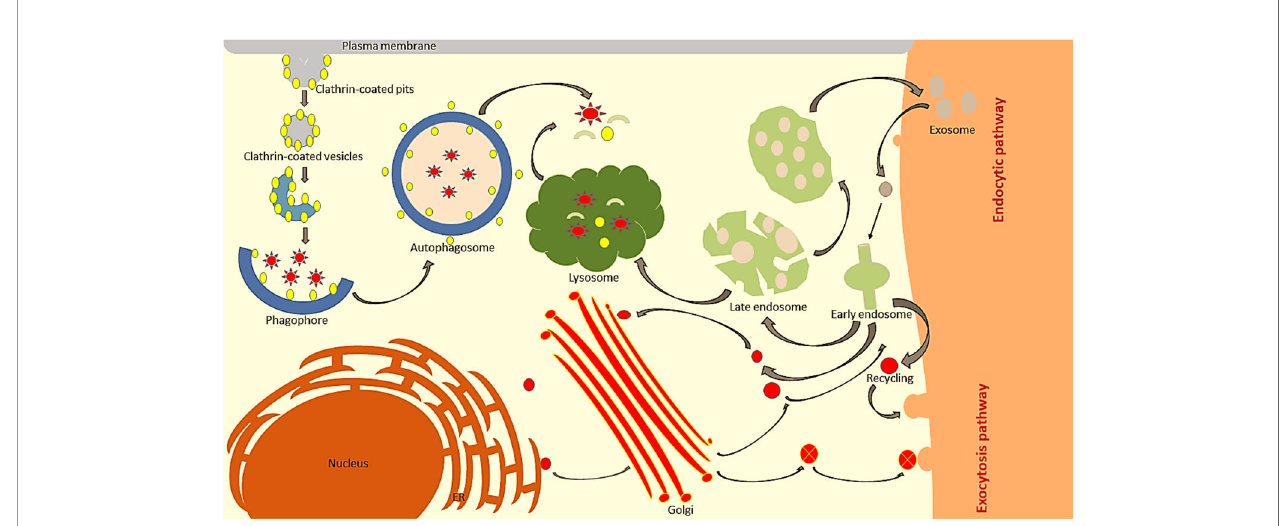
FIGURE 1 | In eukaryotic cells, membrane traf fi cking is divided into two major pathways. In endocytosis, proteins are internalized from the outer cell surface into the early endosomes. The early endosome determines the traf fi cking route for the internalized material, either by sending it to the plasma membrane for recycling, degradation via the lysosome, or for retrieval by the trans-Golgi network. On the other hand, exocytosis translocates newly synthesized proteins into the ER, entering further into the cis-Golgi complex and is transported via the trans-Golgi